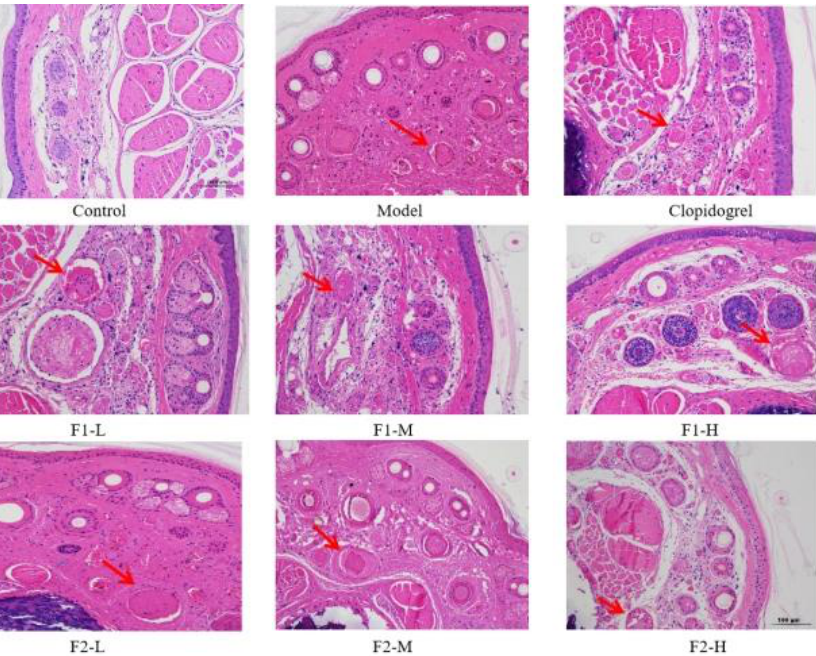
Figure 8. Effects of heparinoid F1 and F2 on carrageenan-induced thrombosis in mice.